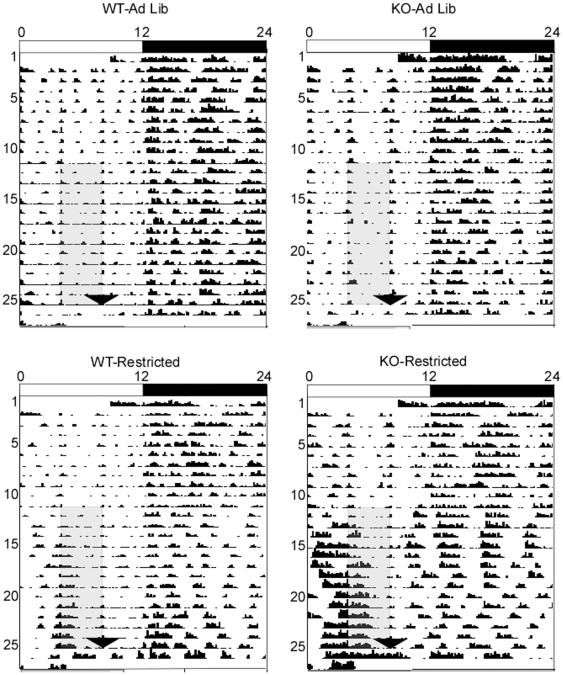
Representative actograms of WT and KO mice under ad libitum feeding conditions or a restricted feeding schedule with two additional days of food deprivation.The light/dark schedule is indicated by white/black bars above, the restricted feeding schedule and corresponding time window for ad libitum-fed control groups are indicated by gray shading. The start of total food deprivation is indicated by inverted triangles on the bottom right-hand corner of the shaded rectangles.